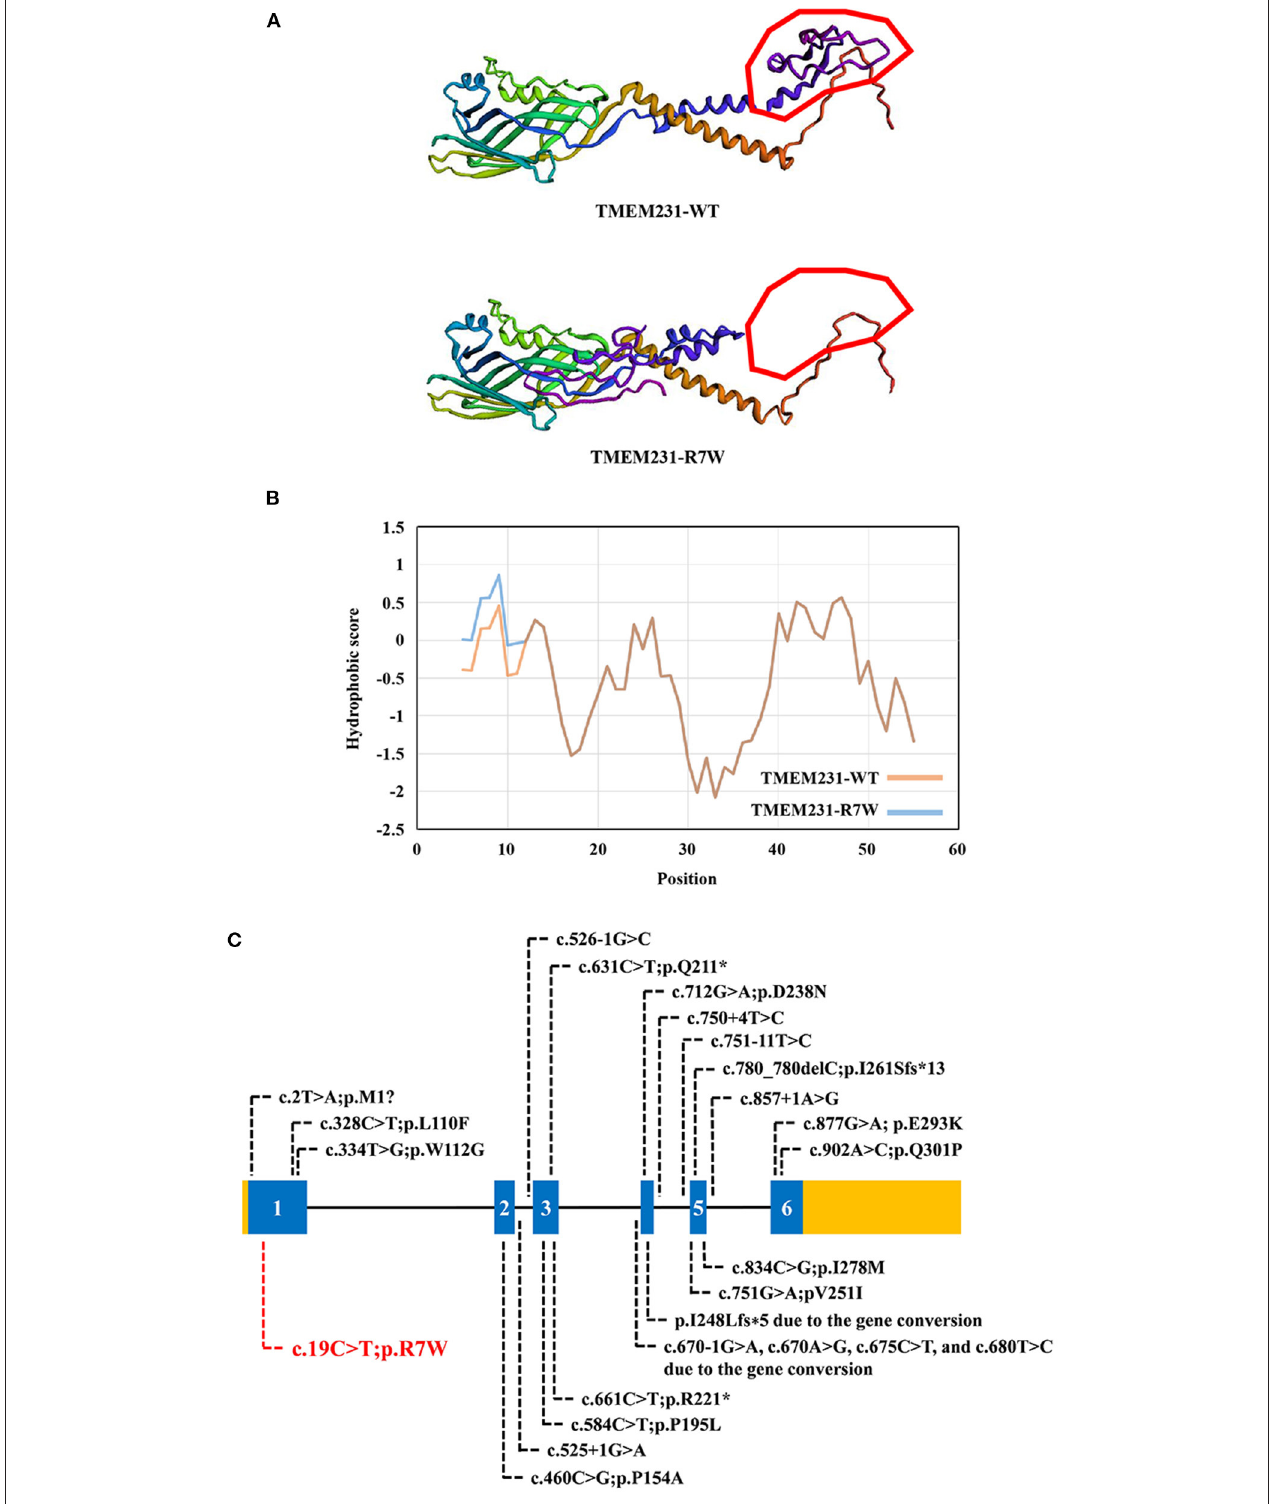
FIGURE 2 | The bioinformatics analysis of mutations. (A) Structure prediction of the mutant protein. The wild-type TMEM231 (TMEM231-WT) protein structure and the p.R7W mutant TMEM231 (TMEM231-p.R7W) protein structure were predicted by SWISS-MODEL online software. (B) The Protscale online software predicts the hydrophobicity of wild-type and p.R7W mutant TMEM231 protein. The yellow curve shows the hydrophobicity score of each amino acid of wild-type TMEM231. The blue curve shows the p.R7W mutant TMEM231. (C) Schematic of TMEM231 mutations identified in JBTS- and MKS-affected individuals. The TMEM231 gene is showed, with all currently known TMEM231 mutations (black letters) and novel mutation (red letters).